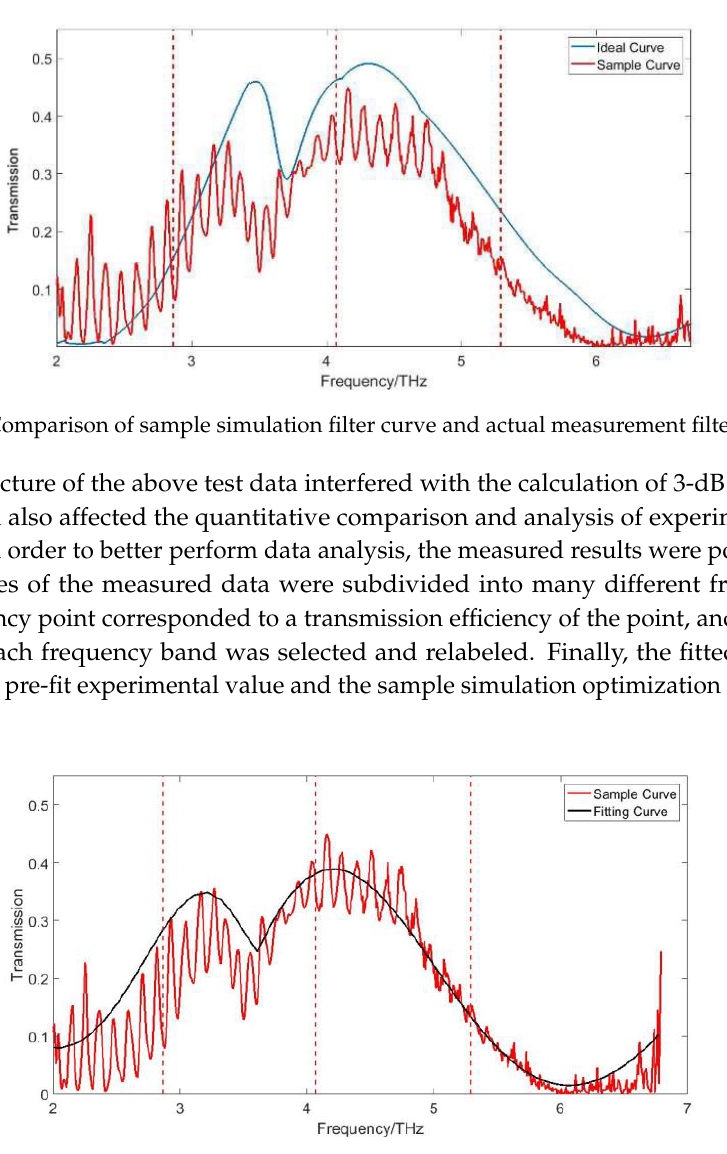
Figure 8. Comparison of actual measurement curve and fitted curve.